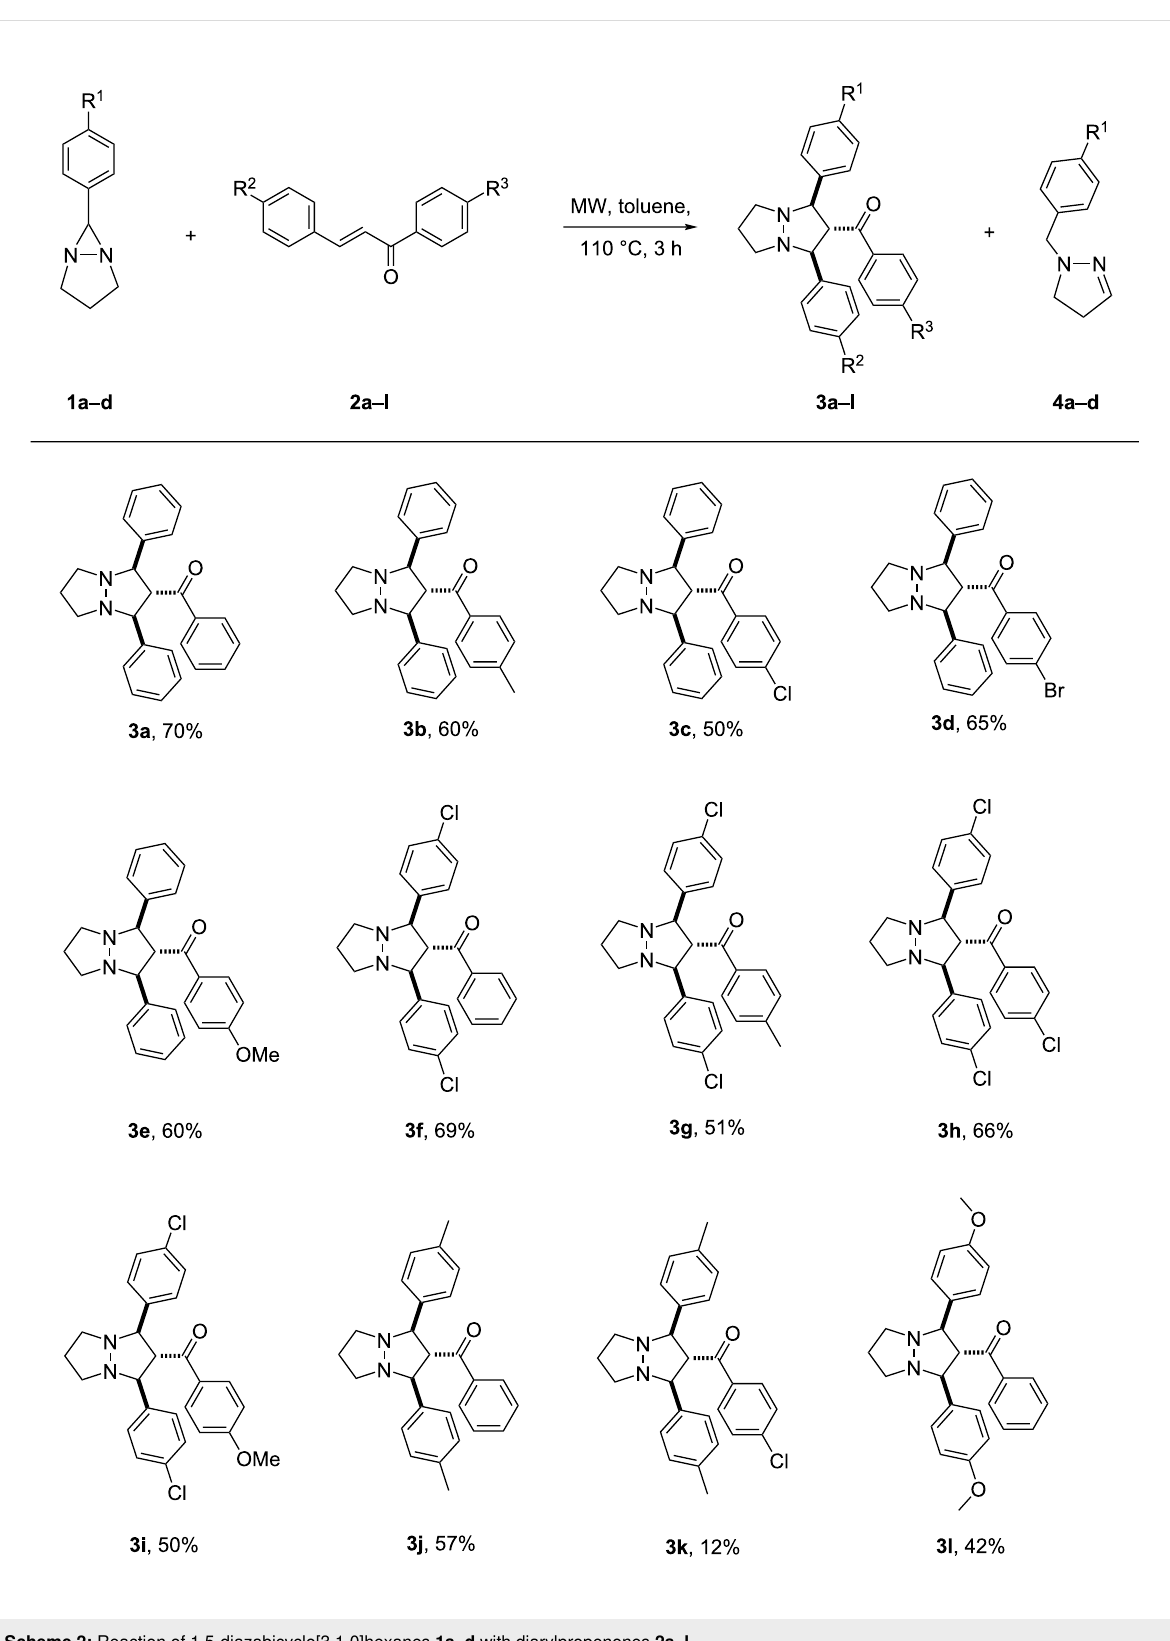
Scheme 2: Reaction of 1,5-diazabicyclo[3.1.0]hexanes 1a–d with diarylpropenones 2a–l